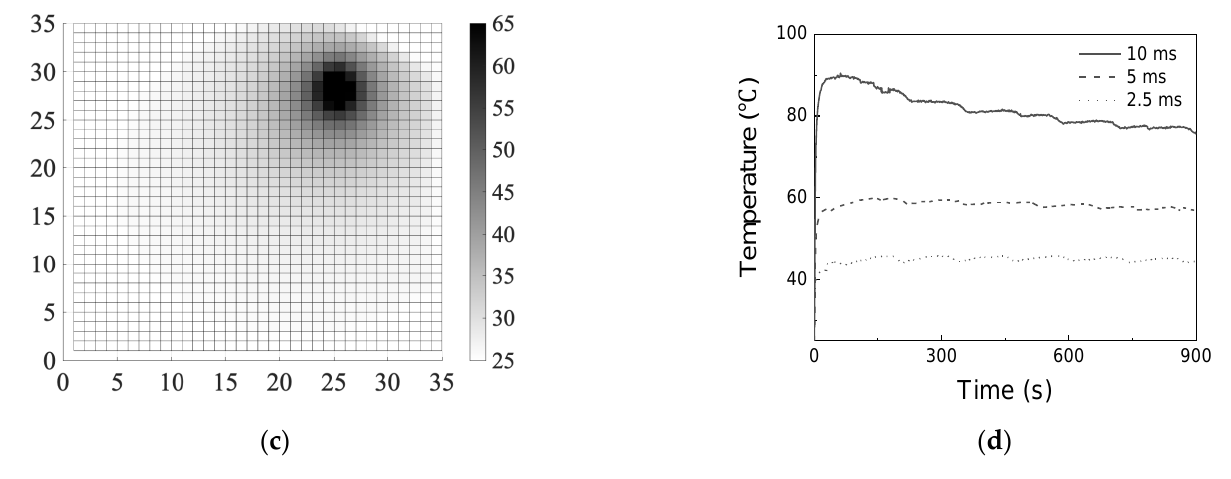
Figure 6. The temperature gradient of the surface of the solid dye. The irradiated pumping laser pulse was adjusted to ( a ) 2.5 ms, ( b ) 5 ms, and ( c ) 10 ms for 900 s. ( d ) The variation in the highest temperature of the irradiated surface of the solid dye.